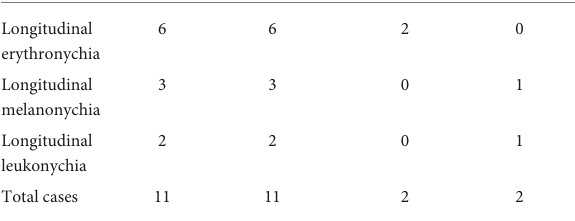
TABLE 1 Clinical presentations of